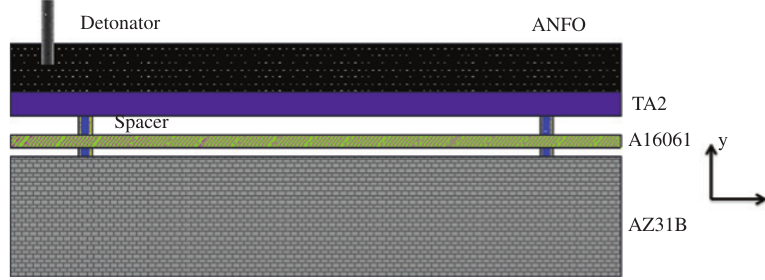
Figure 2: The schematic drawing of the explosive welding.